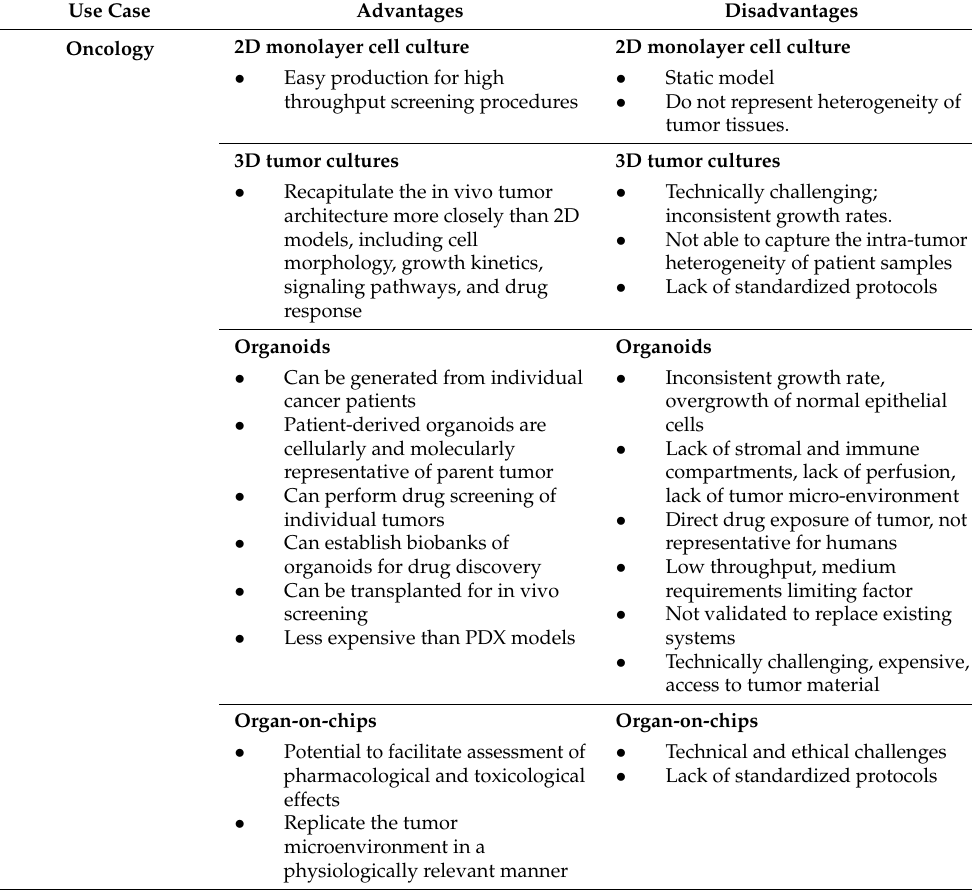
Table 2. In vitro methods for personalized